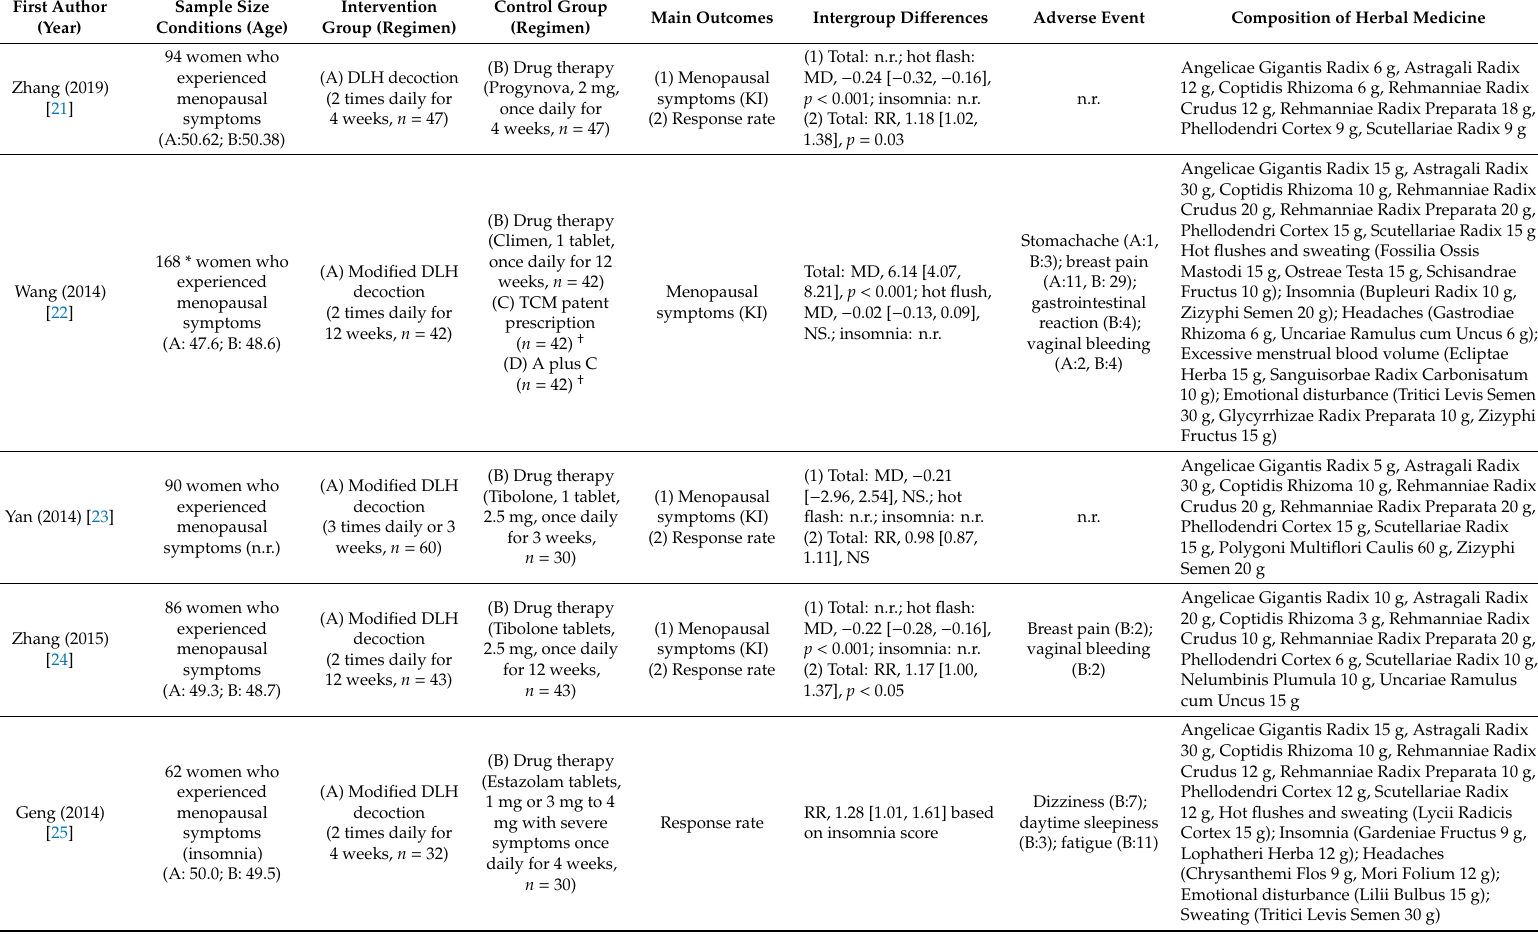
Table 1. Summary of randomized clinical studies of Danggui Liuhuang (DLH) decoction for menopausal